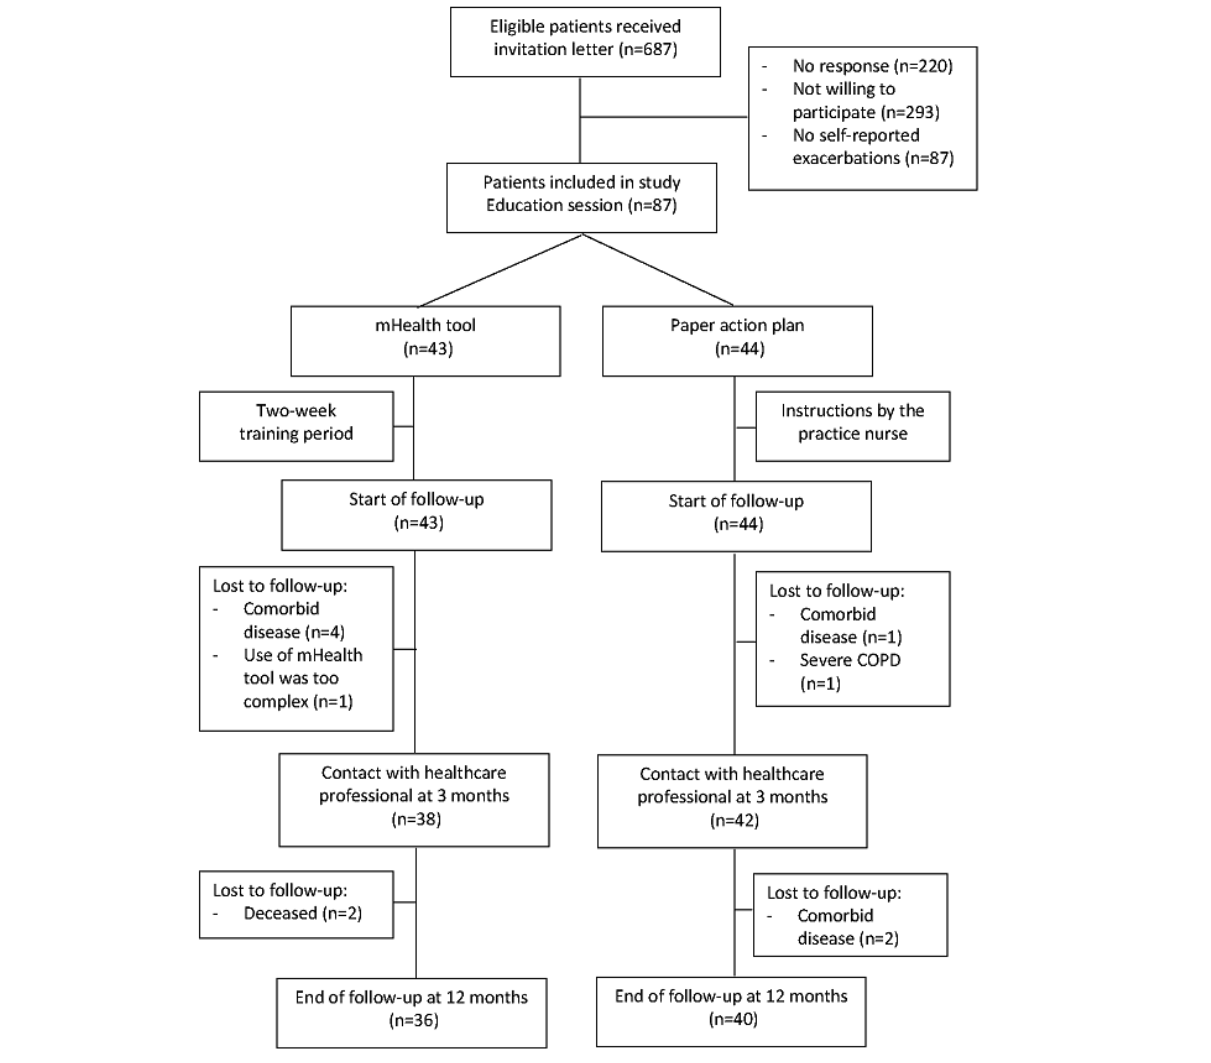
Figure 1. Flow diagram of the participants through the study. mHealth: mobile